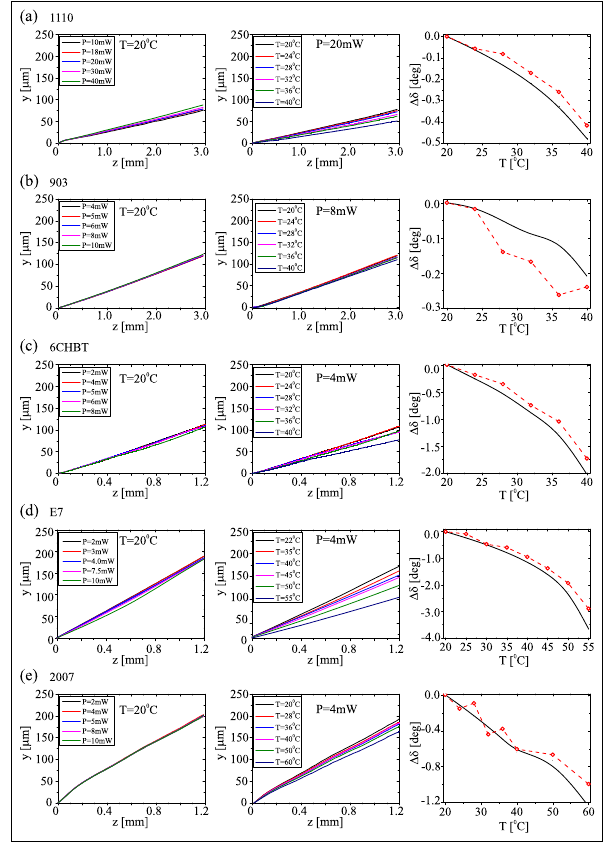
Figure 3. ( Left ): beam trajectory vs. power. ( Center ): beam trajectory vs. temperature. ( Right ): comparison of calculated and measured walk-off changes with respect to its initial value.